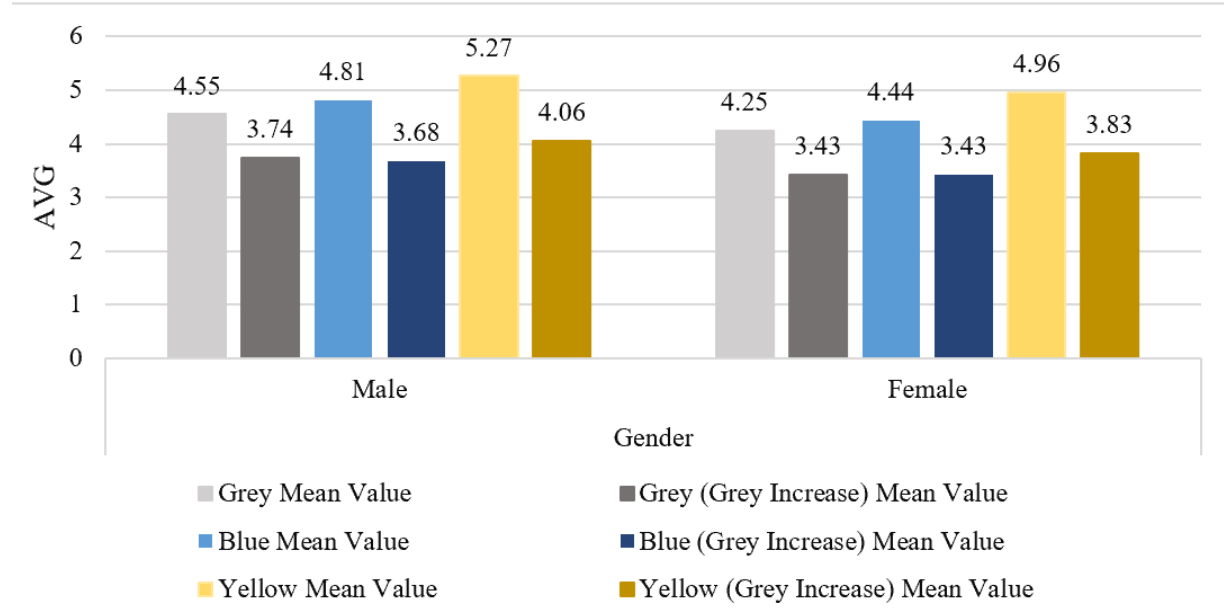
Figure 8. Gender differences in emotional perception of color.